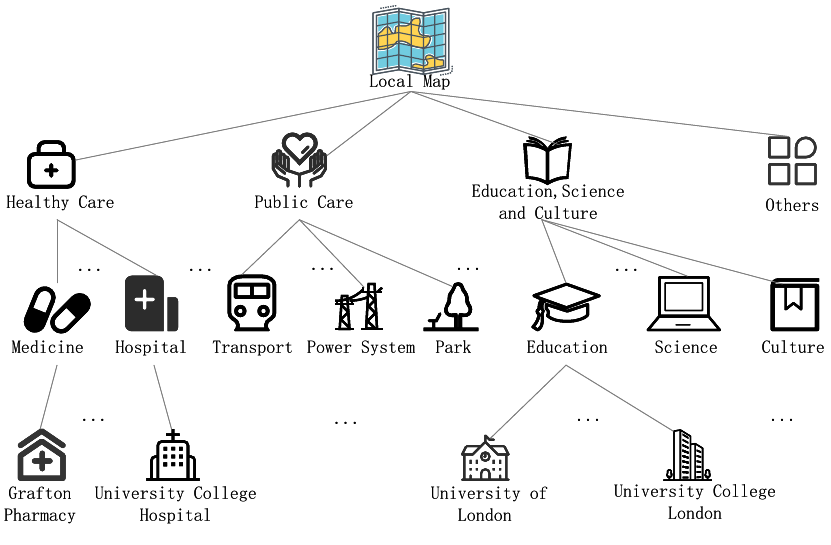
Figure 10. The location semantic